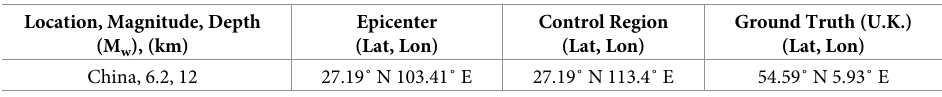
Table 2. Investigated seismic regions and their